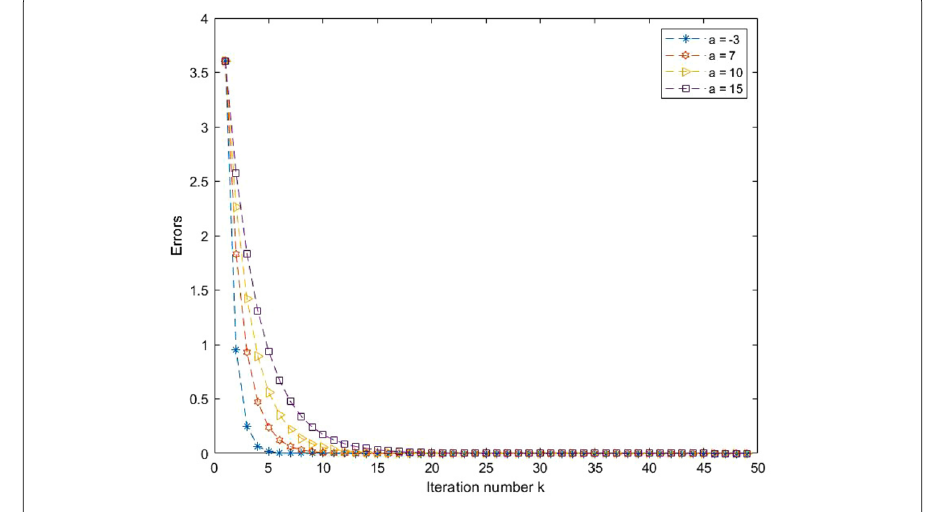
Figure 2 Error for Ex. 4.2